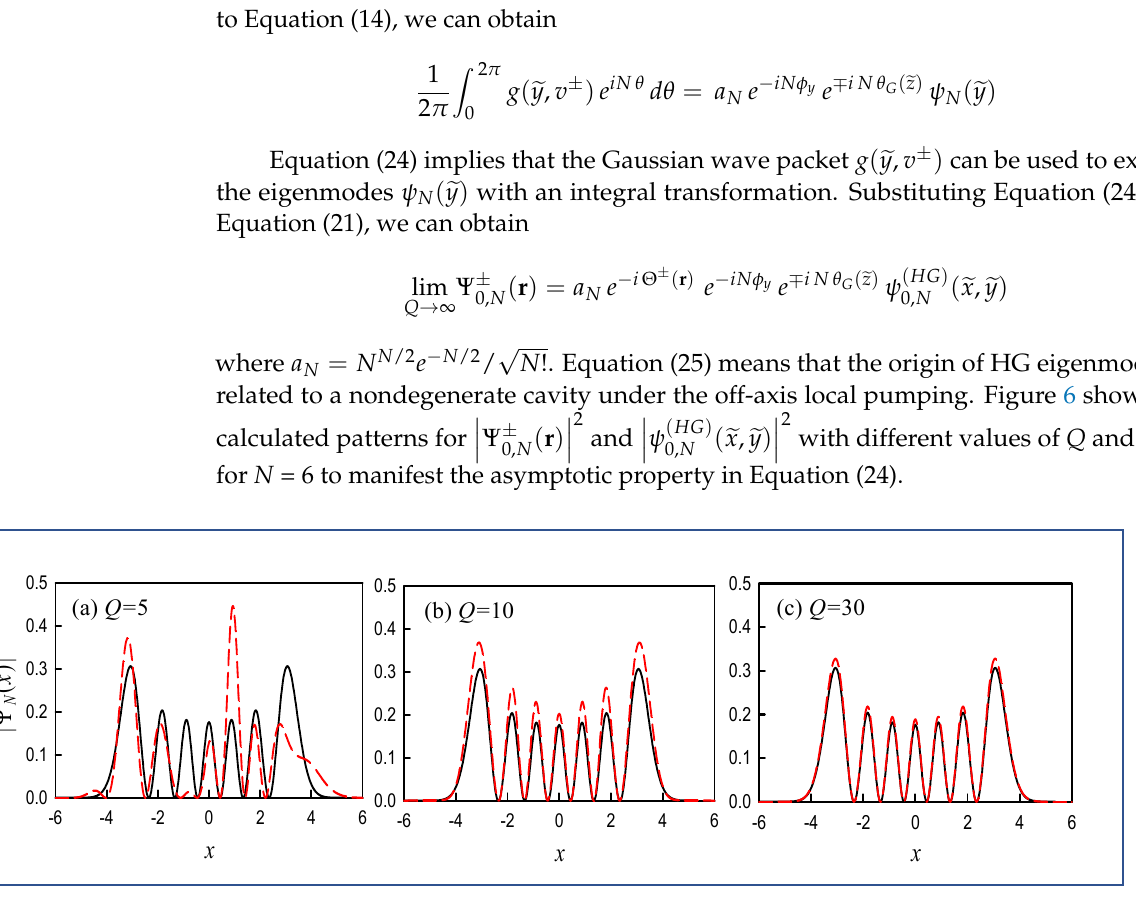
(cid:12) (cid:12) ± Ψ r (dashed lines) and ( ) 2 2 | ( ) | Ψ ± (cid:12) (cid:12) ( r ) (dashed lines) and N 0, (cid:12) (cid:12) 0, N